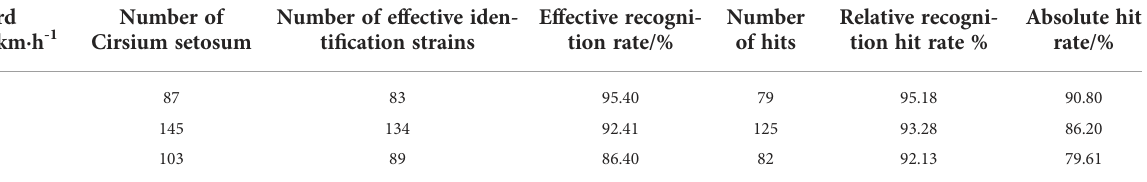
TABLE 3 Statistical results of the spray-on-target test.